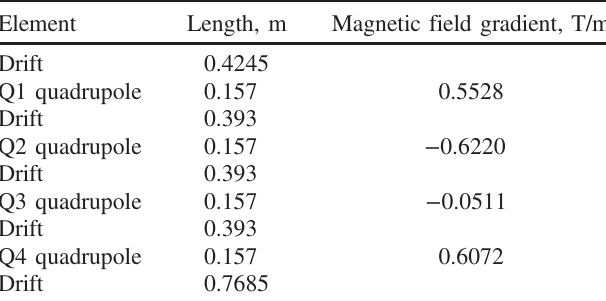
TABLE III. Lattice of the modulator section. Element